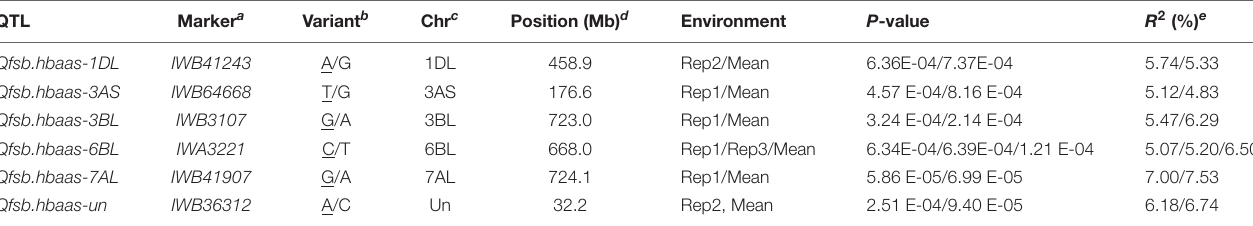
TABLE 3 | Loci significantly associated with FSB resistance in at least two environments in the 240 wheat cultivars (lines) using the mixed linear model (MLM) model in Tassel v5.0. QTL Marker a Variant b Chr c